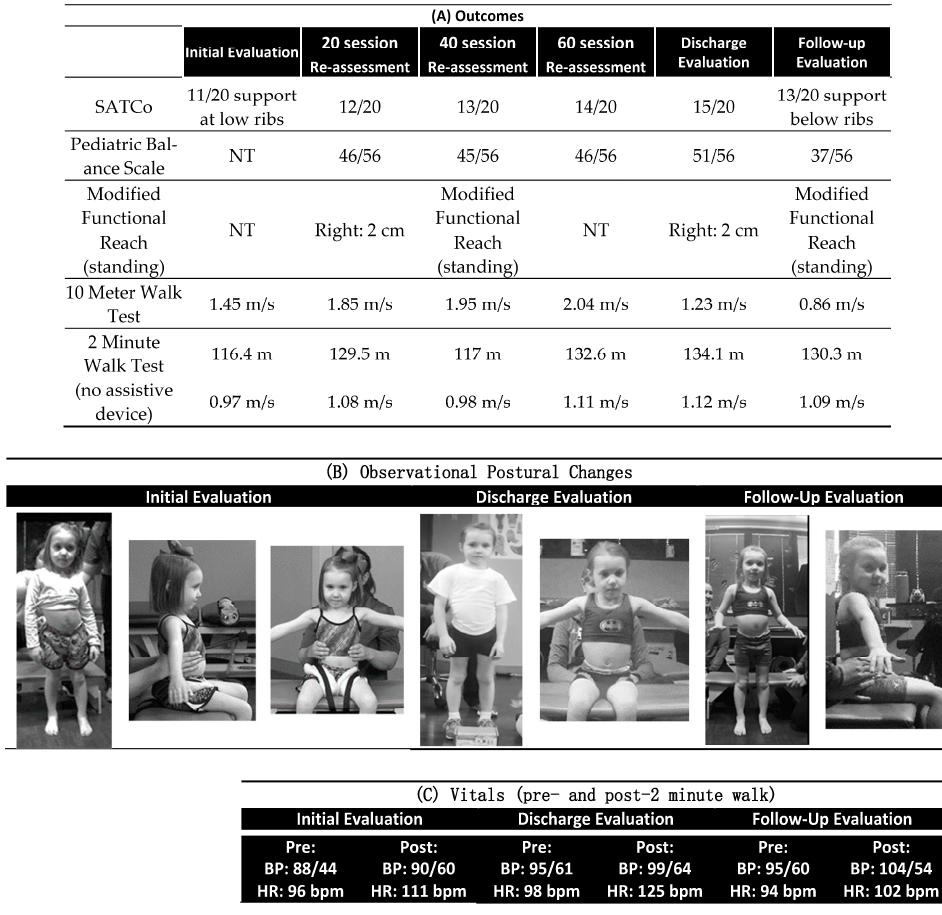
Figure 2. ( A ) Outcome measure scores from 20 session re ‐ assessments (initial evaluation through follow ‐ up evaluation. ( B ) Observational Postural Changes = Improved symmetry of shoulder height, decrease in trunk lateral curve and more equal weight bearing on the legs in standing and through the pelvis in sitting. ( C ) Vitals taken pre ‐ and post ‐ 2 ‐ minute walk test. NT = This test was added to the program’s standardized measurement bank after this patient’s initial evaluation. SATCo = Segmental Assessment of Trunk Control, m/s = meters/second, BP = blood pressure, HR = heart rate, bpm = beats per minute, cm = centimeters.